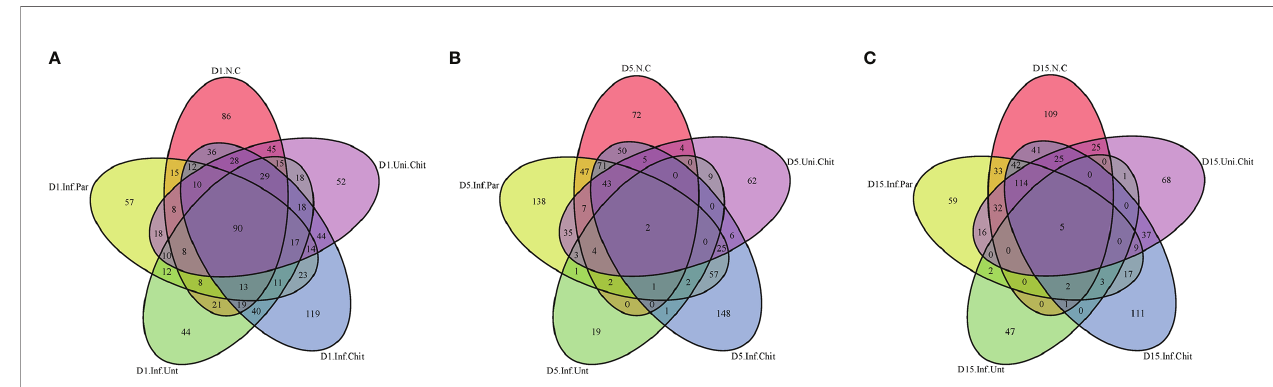
FIGURE 4 | Unique and shared OTUs analysis of the different samples. Venn diagram explaining the overlap in gut microbiota ASVs/OUTs between the N.C, Inf.Unt, Inf.Par, Inf.Chit, and Uni.Chit groups. (A) Day 1 post-infection, (B) day 5 post-infection, and (C) day 15 post-infection total richness of OTUs shared between different groups.